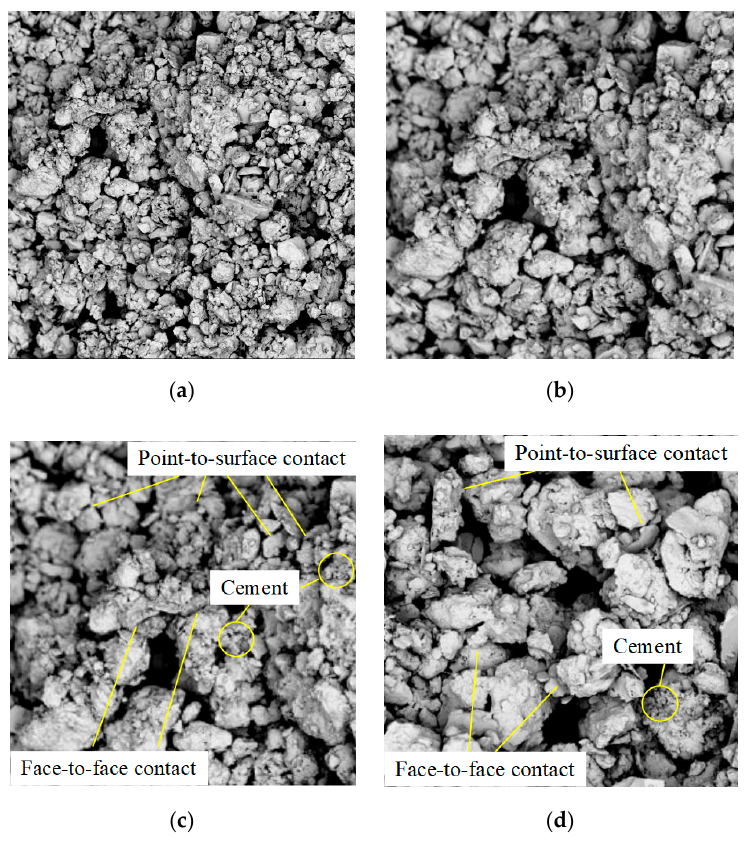
Figure 4. SEM Image. ( a ) 500×, ( b ) 1000×, ( c ) 1500×, ( d ) 2000×.